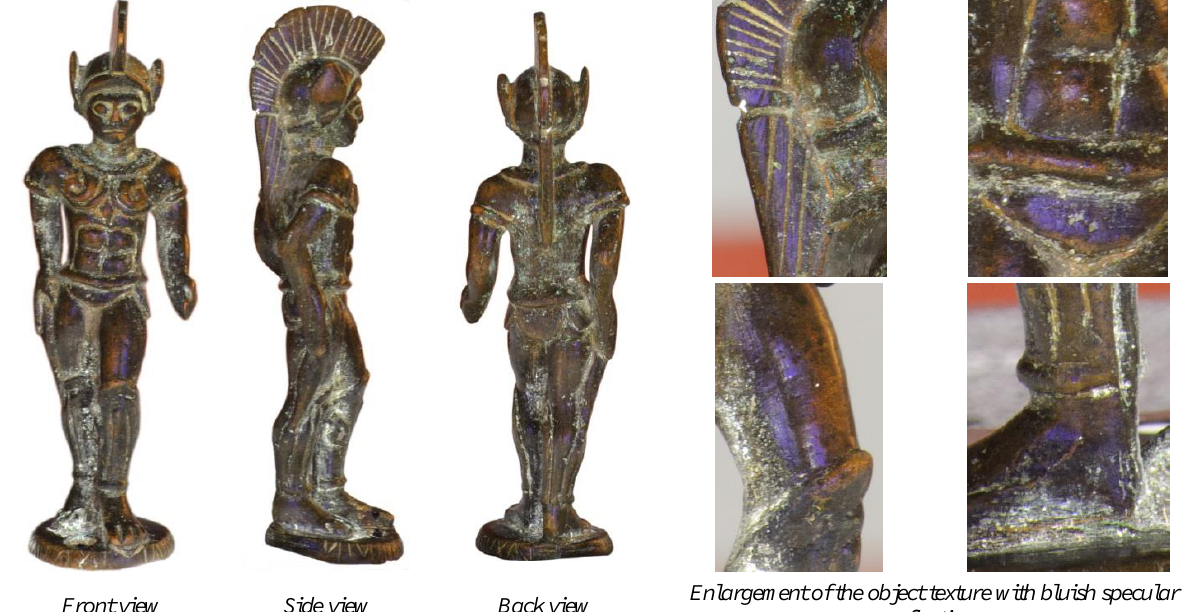
Figure 4. Bronze statuette depicting Roman Mars (Collections of Castello del Buonconsiglio Museum, Trento, Italy).